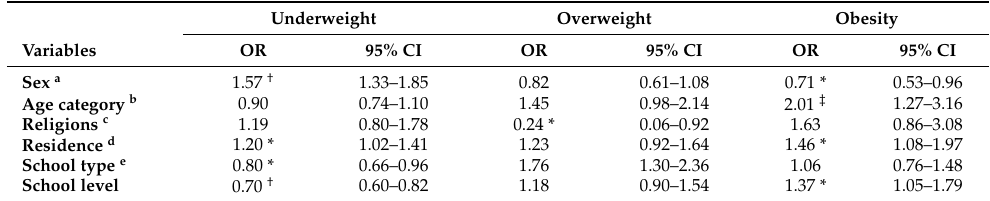
Table 6. Odds ratios of three (binary) logistic regression analyses for the association of underweight, overweight, and obesity with different demographic factors. Underweight Overweight Obesity Variables OR 95%